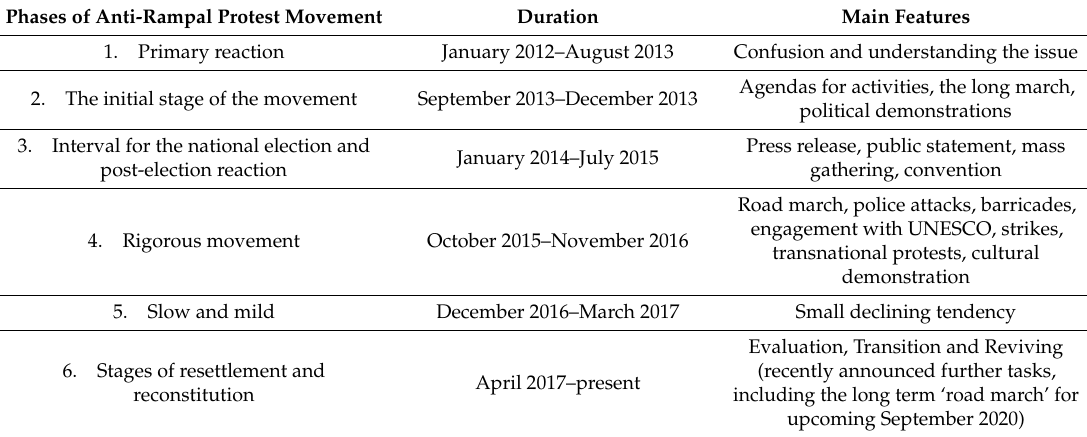
Table 2. Phases and Features of Sundarban Anti-Rampal